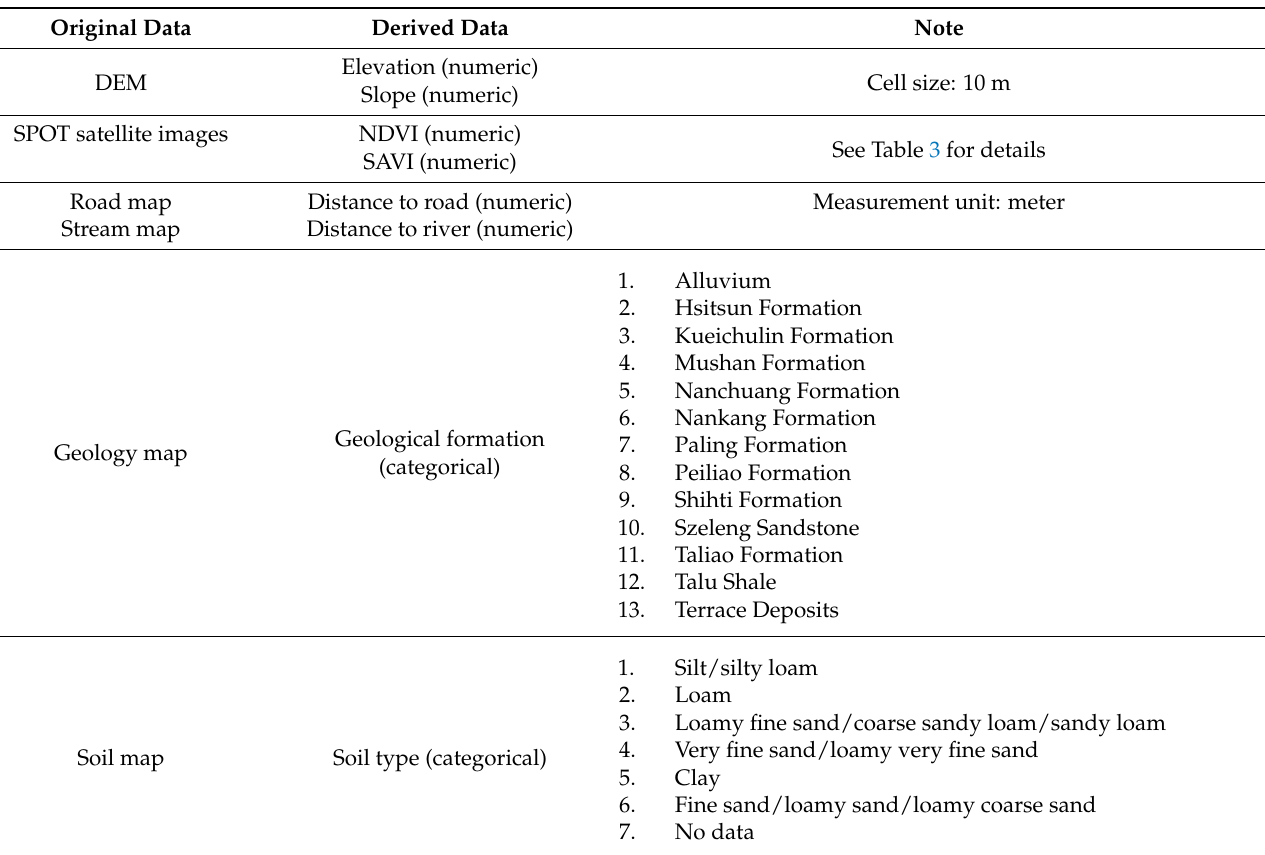
Table 2. Types of geospatial data that were used in this study.